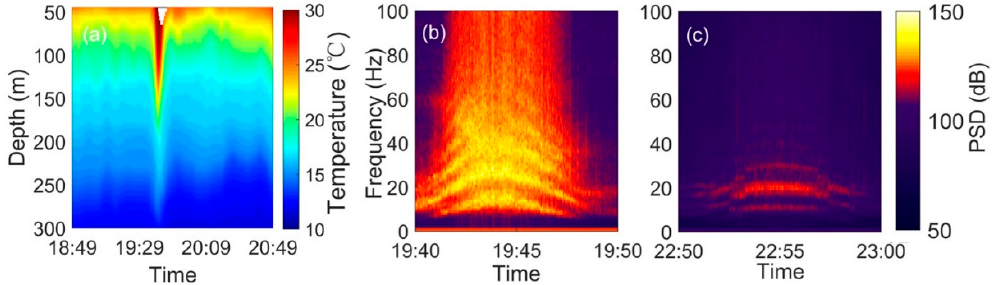
Figure 8. Temperature data and noise of the same ISW received by two hydrophones on 9 July 2019. ( a ) Temperature measured by the thermistor chains. ( b ) Time–frequency spectrum from a hydrophone at a depth of 250 m. The cable of the hydrophone array is 300 m long. ( c ) Time–frequency spectrum from the near–bottom hydrophone at a depth of 340 m. The cable of the single hydrophone is 30 m long.